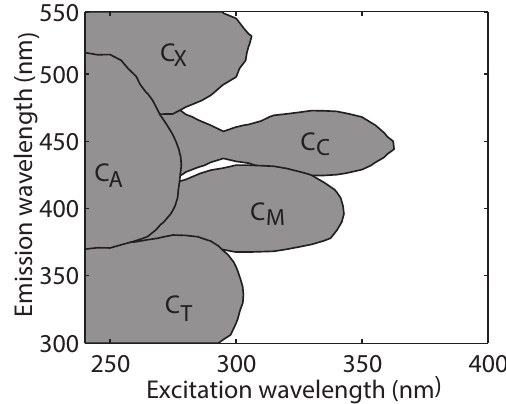
Fig. 2. Outline of peak locations for all five DOC fluorescence PARAFAC components. Outlines were drawn at equal excita- tion/emission loadings among